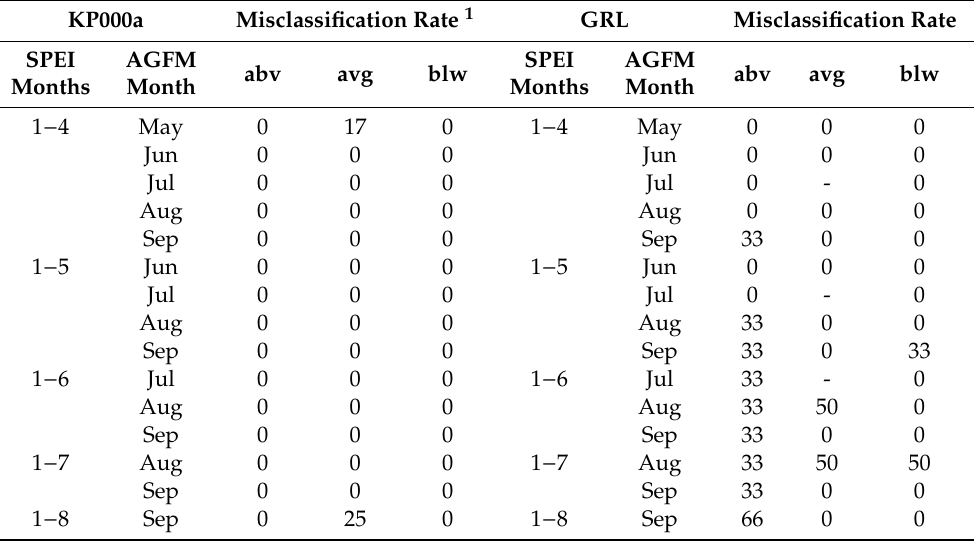
Table 1. Misclassification rate results from the site-specific discriminant analysis of the 1 month time scale standardized precipitation and evaporation indices (SPEIs) and AGFM classifications for the Konza Prairie (KP000a) and GRL research sites. AGFM classifications are: abv = above average, avg = average, and blw = below average.